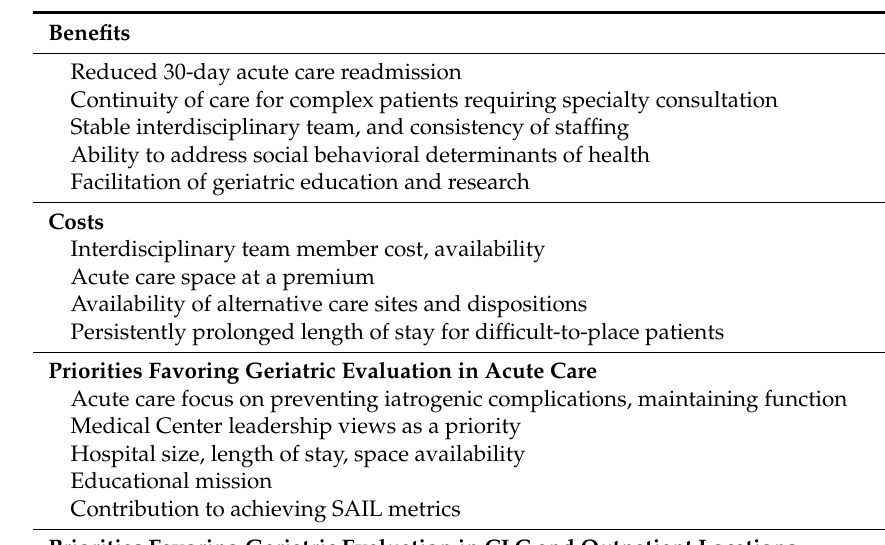
Table 3. Value-added attributes of geriatric evaluation